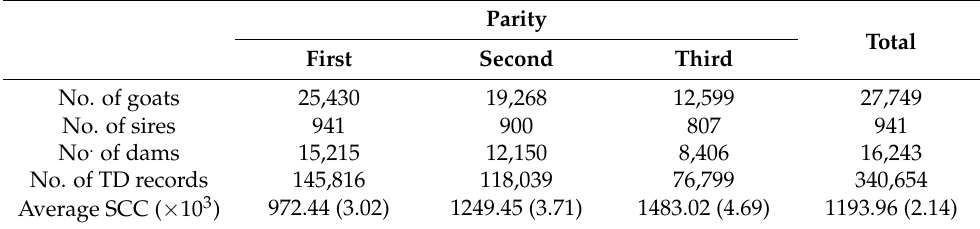
Table 1. Number of goats and records by parity used in the SCC (somatic cell count) genetic analysis (standard error between